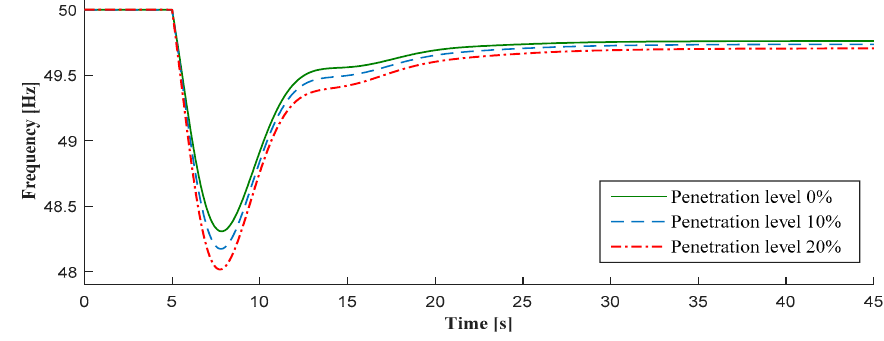
Figure 3. Frequency response with different wind power penetration level without frequency control.